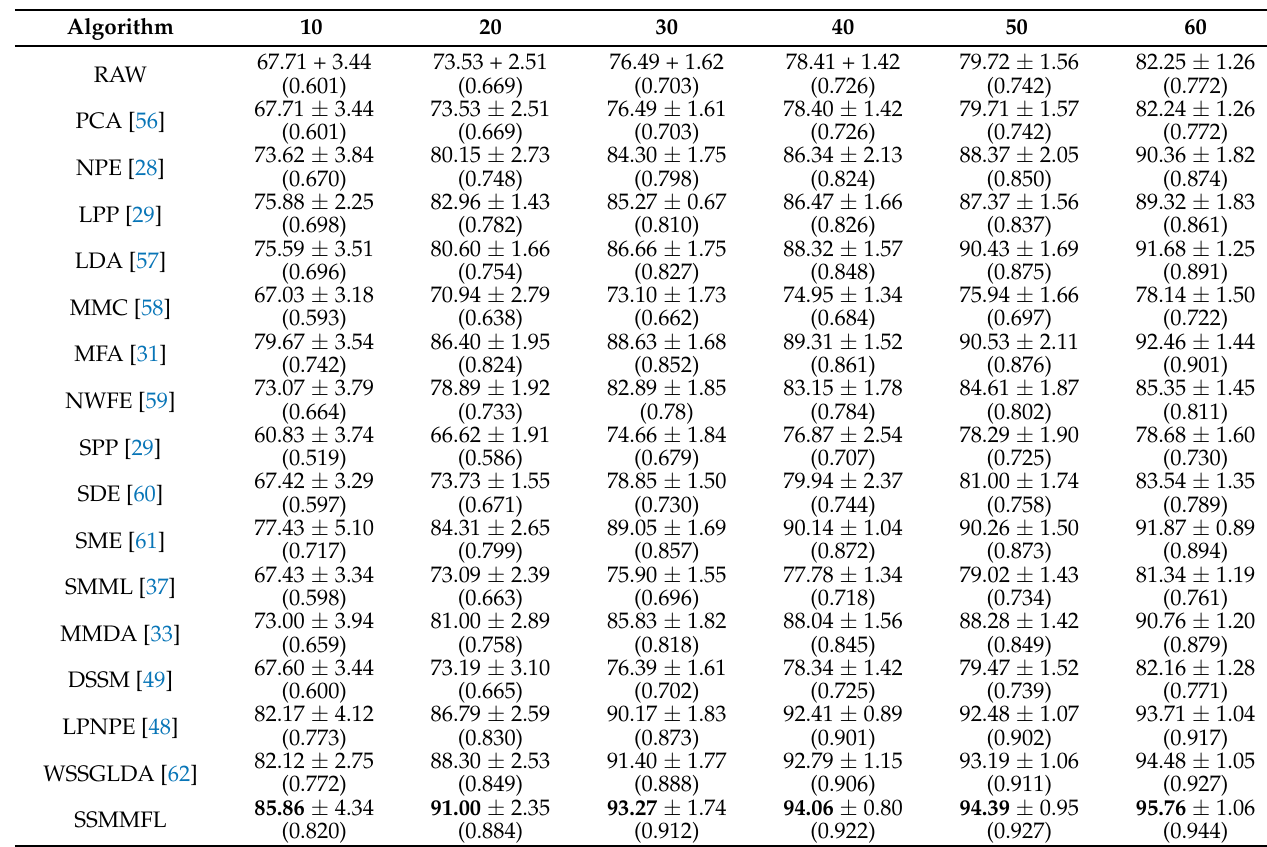
Table 1. Classification results with different values of n i on the PaviaU dataset with nearest neighbor (NN) classifier. Each method has two rows, where the first row is the OA ± STD (%) and the second row is the Kappa coefficient